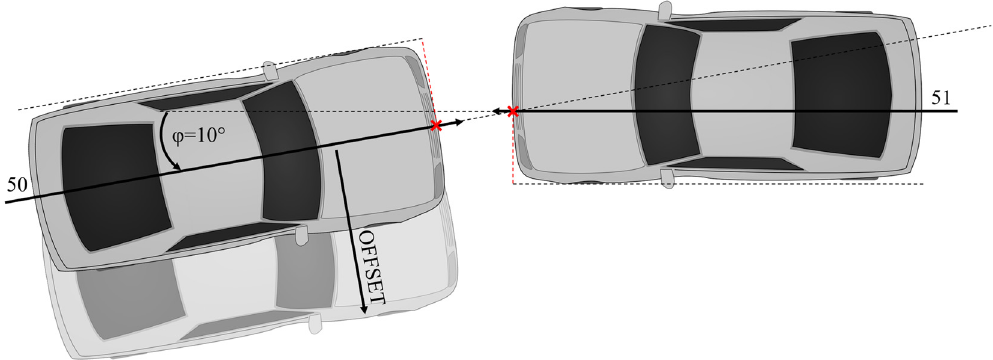
Figure A2: Collision position for scenario G – front impacts 50 and 51.